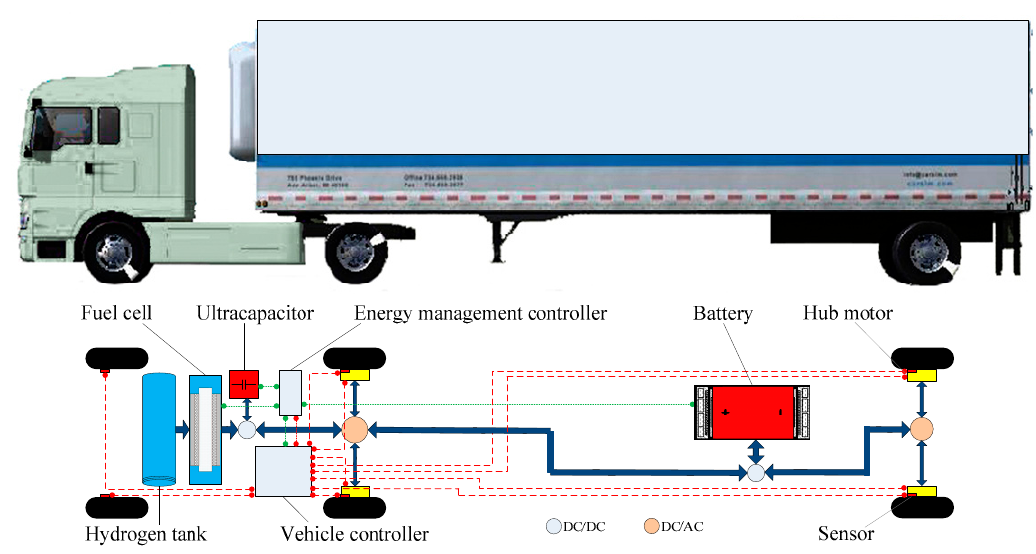
Figure 1. Configuration of components in the proposed fuel-cell electric articulated vehicle.